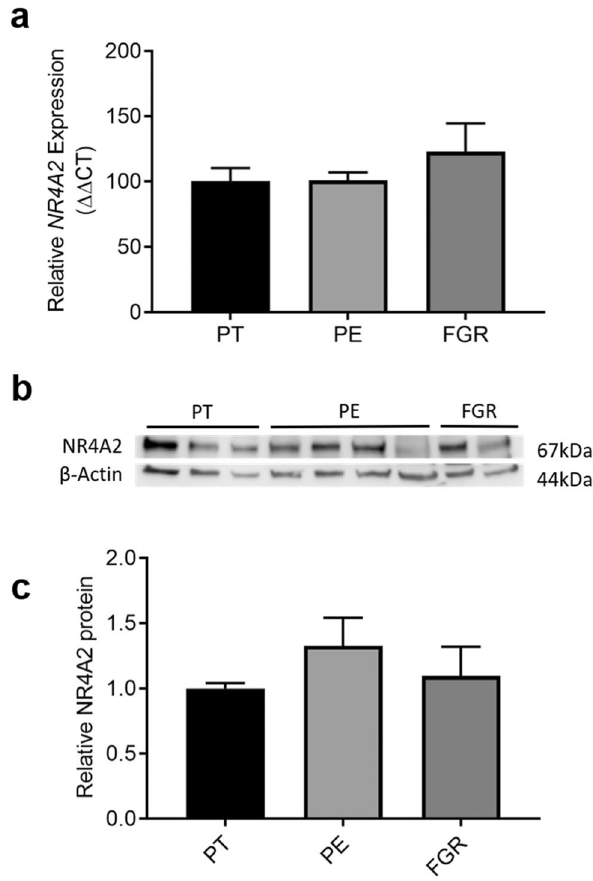
Figure 3. NR4A2 expression and protein in preterm control (PT), preeclamptic (PE) and fetal growth restricted (FGR) placental tissue (≤ 34 weeks gestation). ( a ) mRNA expression assessed by qPCR. ( b ) Representative western blot. ( c ) Densitometric analysis of western blot. NR4A2 expression was not altered in the PE and FGR placental tissue compared to respective PT control tissue (PT n = 10, PE n = 49, FGR n = 14). There was no significant difference in NR4A2 protein between the pathological and control tissue (PT n = 15, PE n = 31, FGR n = 17). β-actin acted as the loading control. Data presented as relative change from preterm controls ±